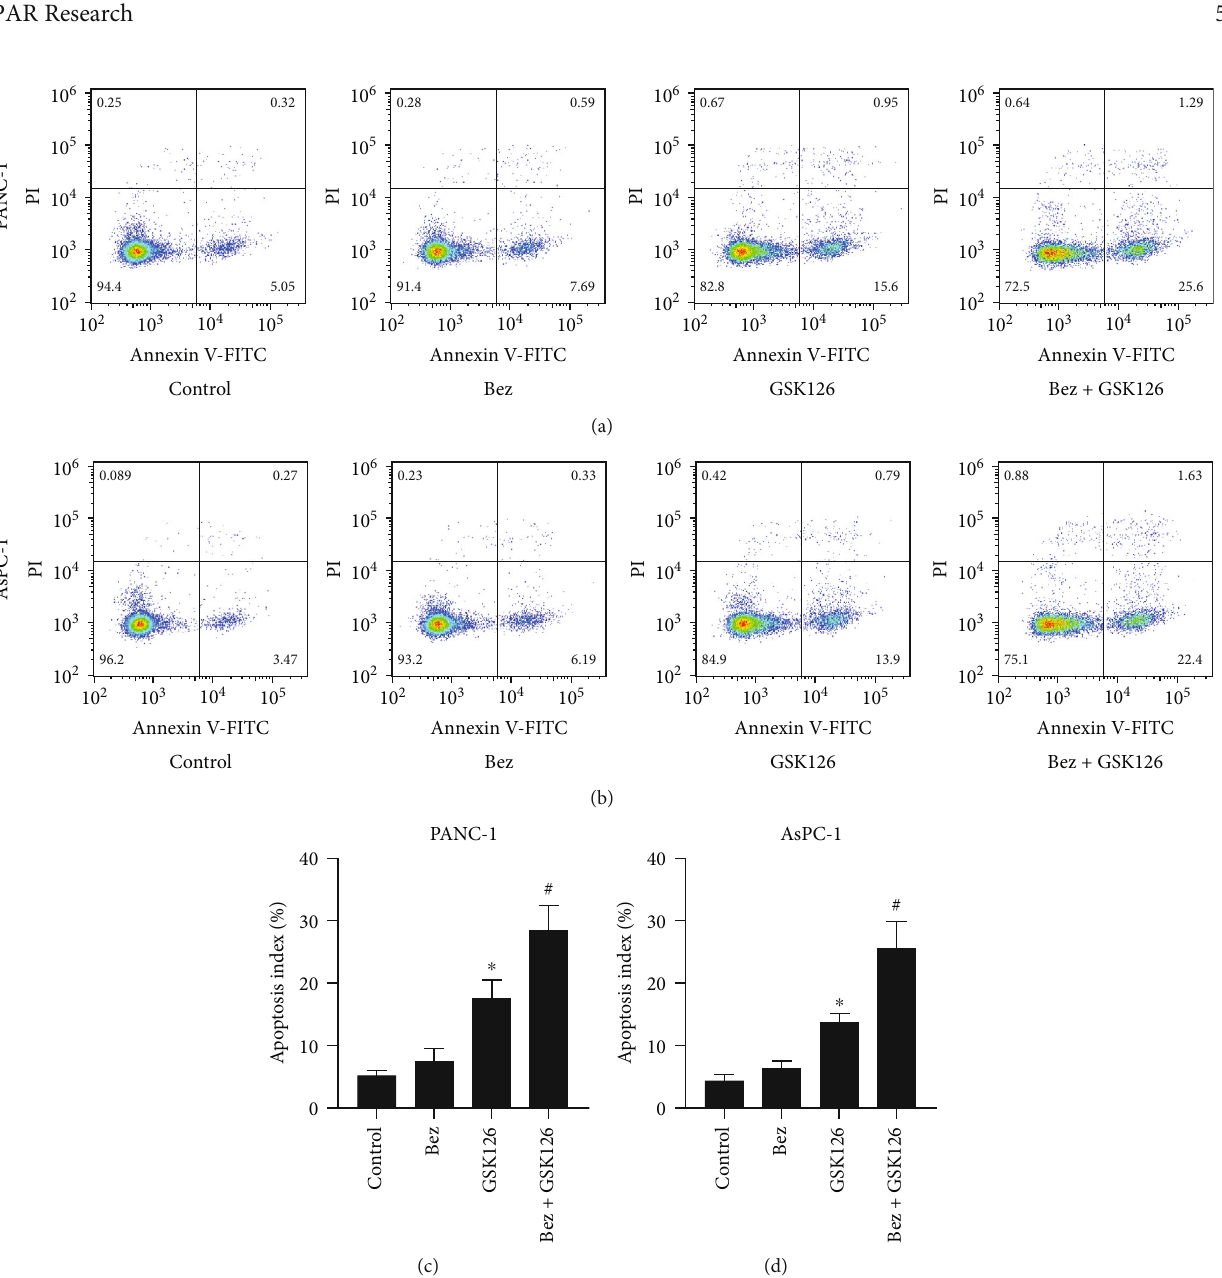
Figure 3: E ff ects of combination of beza fi brate and GSK126 on apoptosis of PANC-1 and AsPC-1. The concentrations of beza fi brate and GSK126 were 1 mM and 20 μ M, respectively. (a) The representative images of fl ow cytometry in each experimental group of PANC-1 cells. (b) The representative images of fl ow cytometry in each experimental group of AsPC-1 cells. (c) Apoptosis rates in each experimental group of PANC-1 cells. (d) Apoptosis rates in each experimental group of AsPC-1 cells. The values were expressed as the means ± S : E : M : ( n = 6 for each group). ∗ P < 0 : 05 vs. control; # P < 0 : 05 vs. the GSK126